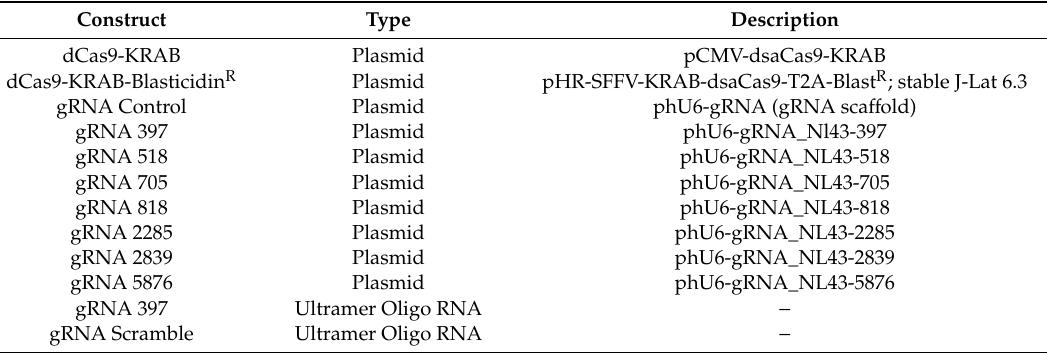
Table 2. Disabled Cas9 (dCas9)